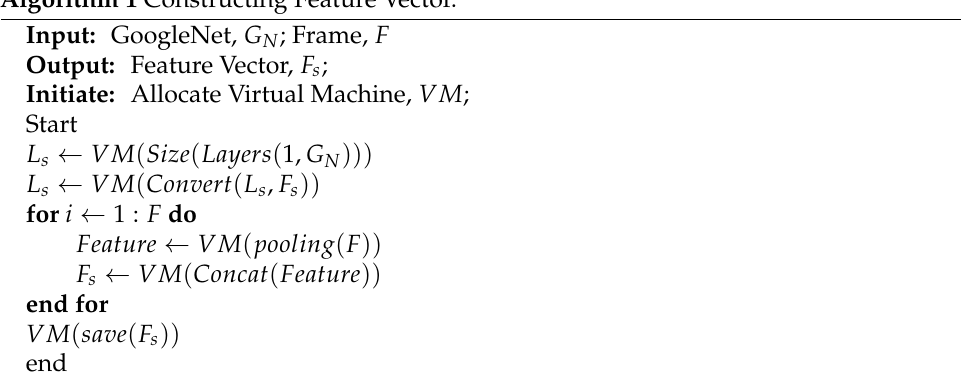
Algorithm 1 Constructing Feature